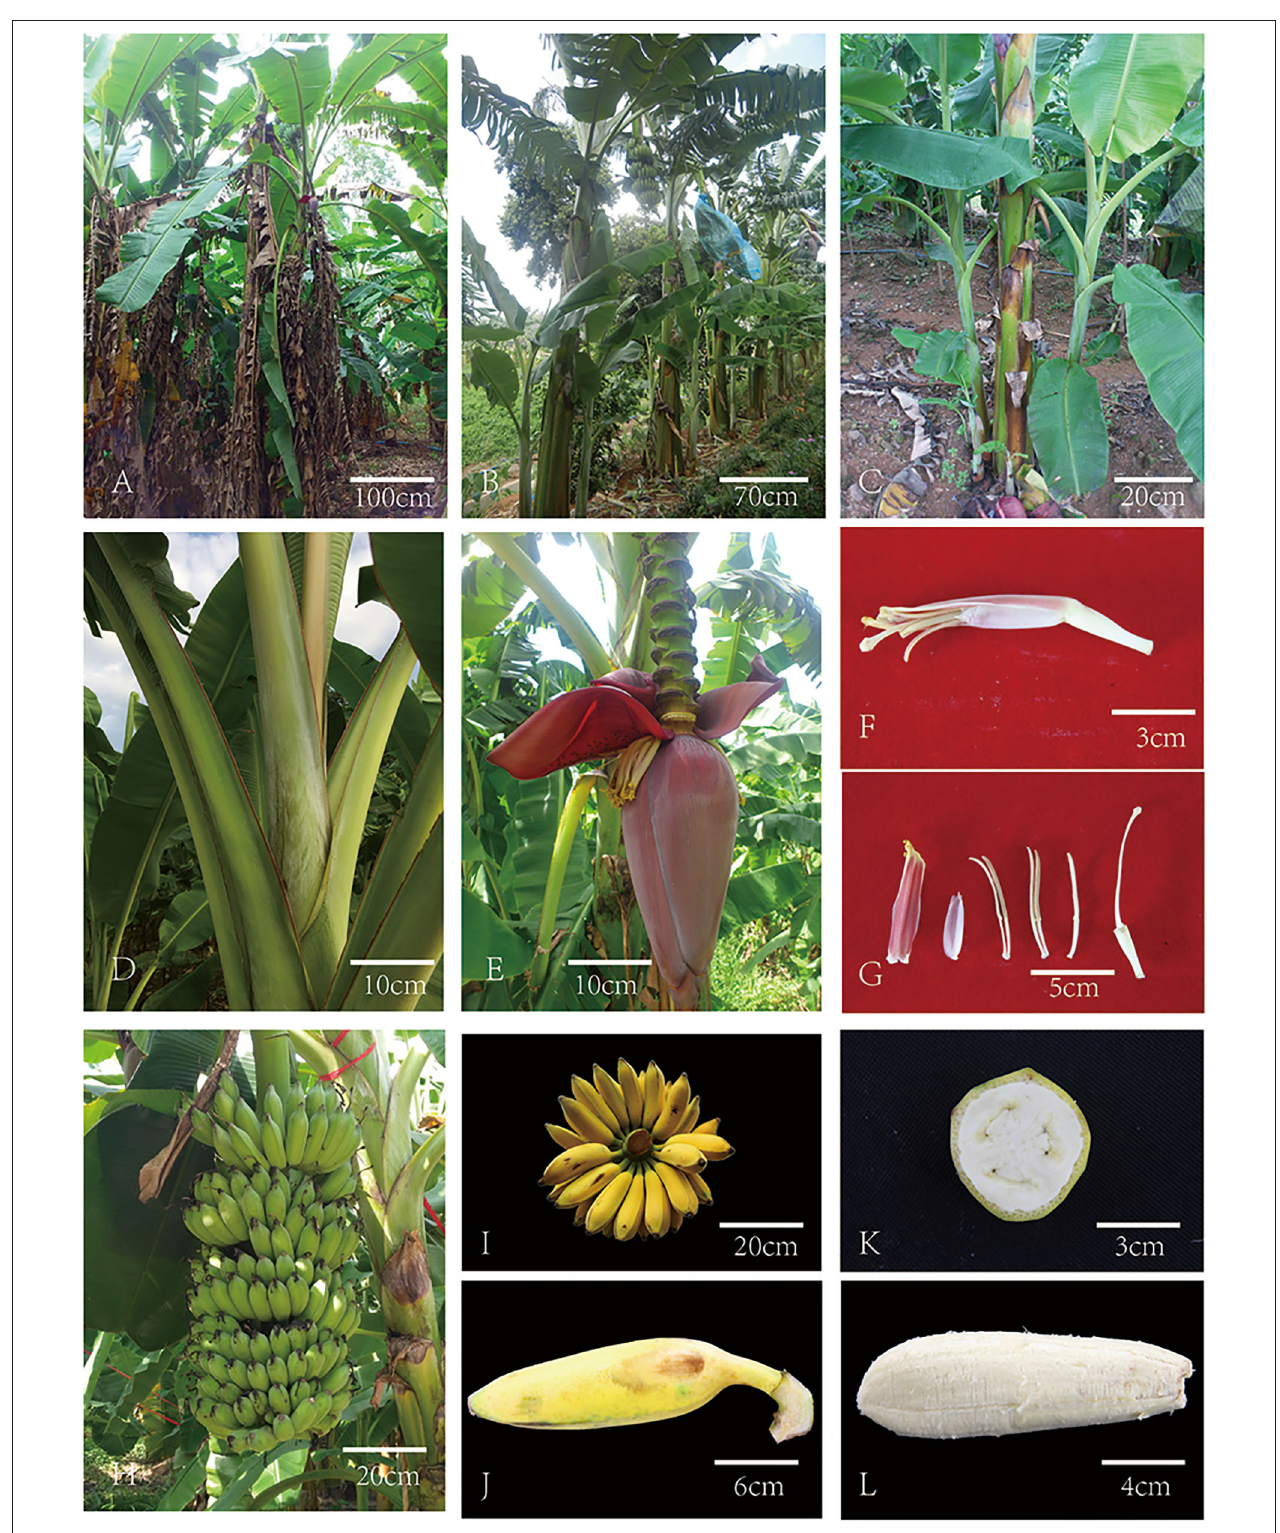
FIGURE 1 | Morphological observations of the ‘ RF1 ’ mutant. (A,B) FJ (bar = 100cm) and RF1 (bar = 70cm) phenotypes. (C,D) RF1 suckers (bar = 10cm) and petiole (bar = 20cm). (E,F) RF1 male bud (bar = 10cm) and male flower (bar = 3cm). (G) RF1 compound tepal, free tepal, filament × 3, ovary and style (from left to right, respectively). Bar = 5cm. (H) RF1 bunch on the tree. Bar = 20cm. (I) RF1 mature fruit. Bar = 20cm. (J) RF1 fruit shape. Bar = 6cm. (K) Arrangement of ovules of RF1 fruit. Bar = 3cm. (L) RF1 fruit pulp. Bar = 4cm. RF1, ReFen 1; FJ, FenJiao.